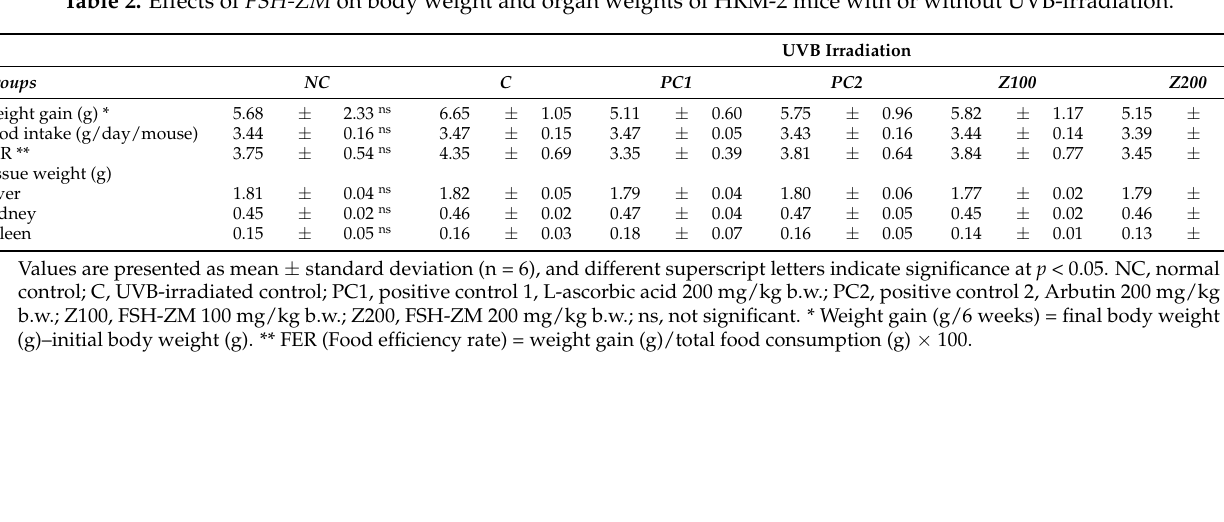
Values are presented as mean ± standard deviation (n = 6), and different superscript letters indicate significance at p < 0.05. NC, normal control; C, UVB-irradiated control; PC1, positive control 1, L-ascorbic acid 200 mg/kg b.w.; PC2, positive control 2, Arbutin 200 mg/kg b.w.; Z100, FSH-ZM 100 mg/kg b.w.; Z200, FSH-ZM 200 mg/kg b.w.; ns, not significant. * Weight gain (g/6 weeks) = final body weight (g)–initial body weight (g). ** FER (Food efficiency rate) = weight gain (g)/total food consumption (g) × 100. 3.3. Effects of FSH-ZM on mRNA Expressions Related to Skin Moisturizing in UVB-Irradiated HRM-2 Mice The mRNA expression of HAS2 was significantly decreased (64.8%) in the C group compared with that in the NC group and significantly increased (127.7%) in the PC1 group compared to the C group. Compared with that in the C group, the groups receiving diet